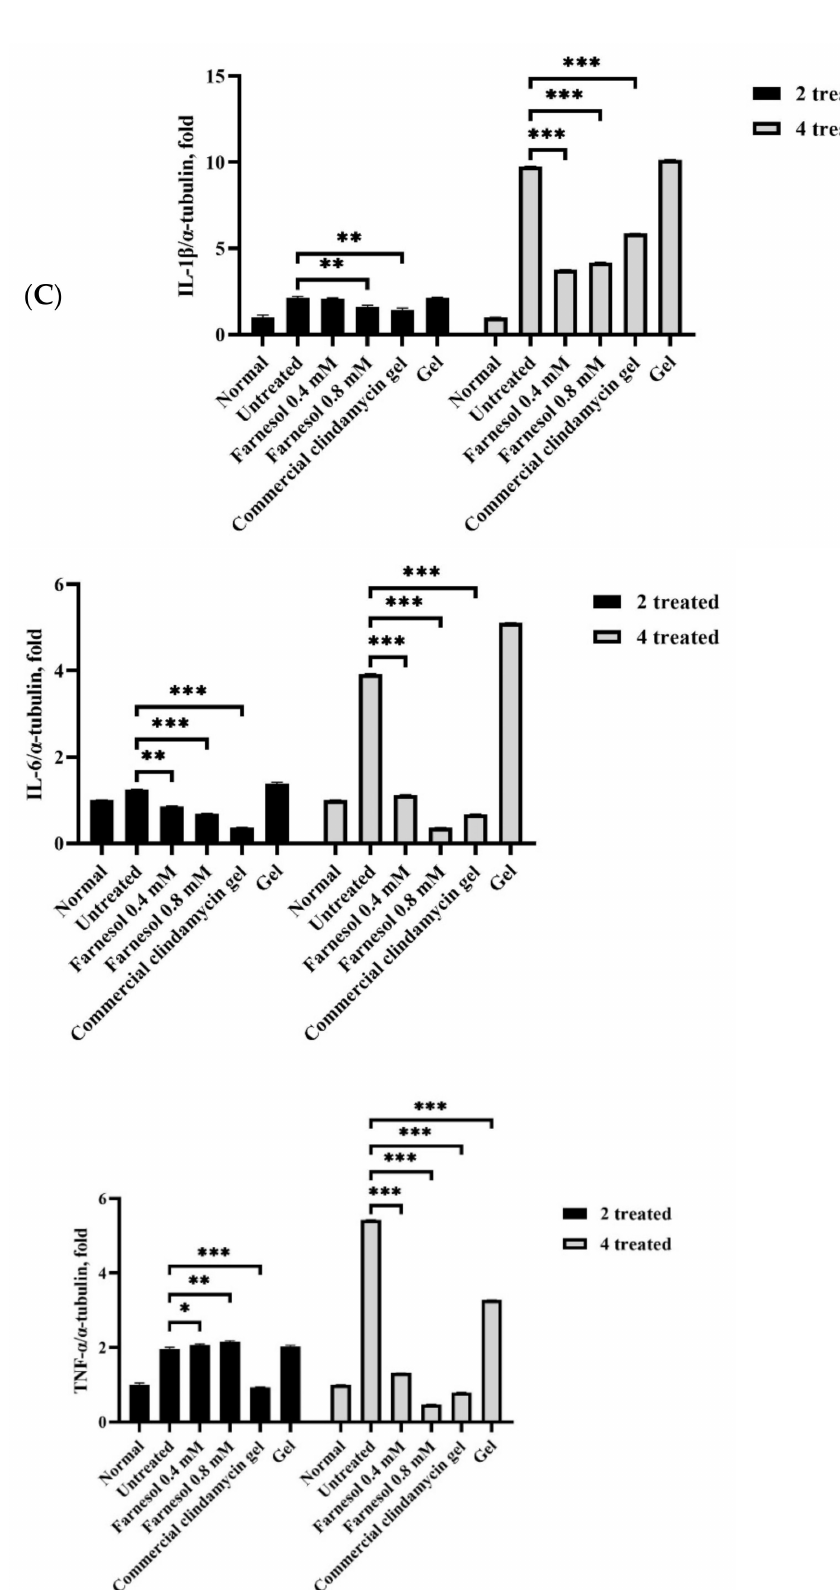
Figure 6. Western blot of the dorsal skin of rats after two-time ( A ) and four-time ( B ) treatment with 0.4 mM farnesol, 0.8 mM farnesol, HPMC, and commercial clindamycin gels. ( C ) Semiquantitative analyses of Western blot of proinflammatory cytokines, using the ImageJ software. * p < 0.05; ** p < 0.01; *** p < 0.001 (compared with the untreated